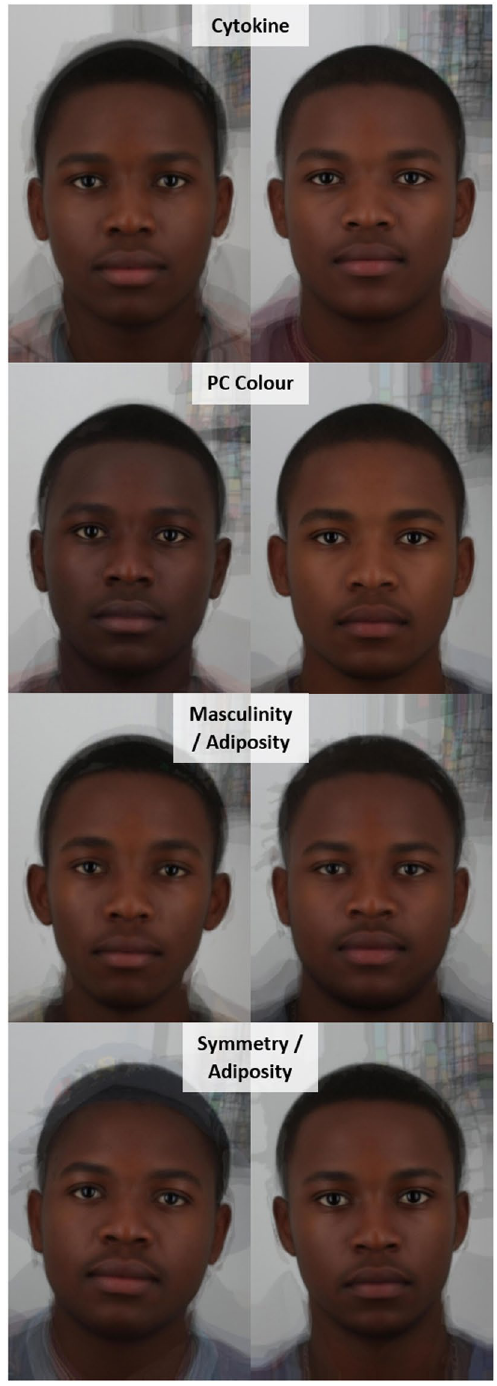
Figure 1. Composite images of cytokine response; PC Colour; the masculinity, adiposity component (PC1); and the symmetry, adiposity component (PC2). Images on the left are composite images of the ten men with the lowest values for that variable, while images on the right are composite images of the ten men with the highest